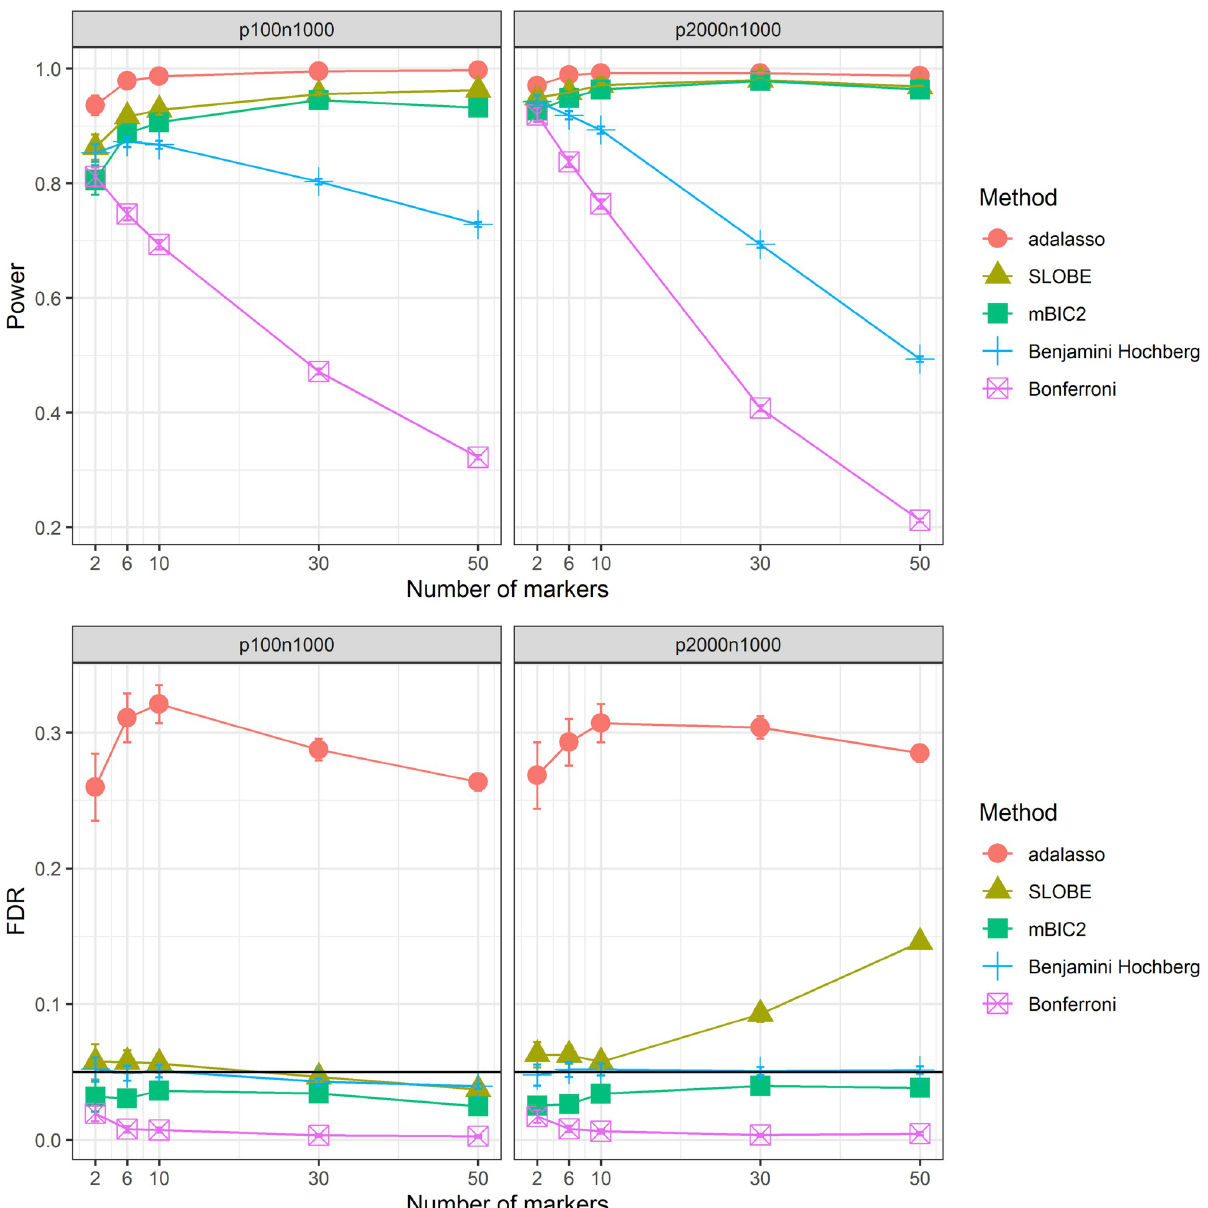
Fig 1. Biomarker identification. Power and False Discovery Rate of biomarker identification as a function of the number of causal variants k for two different simulation scenarios ( p < n and p > n ).